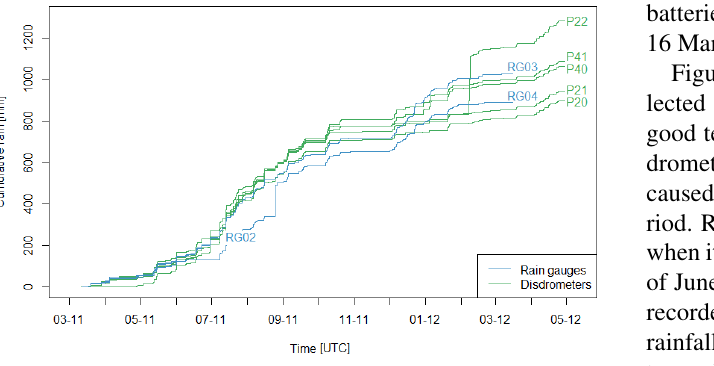
Figure 5. Comparison of cumulative rain of the three rain gauges and five disdrometers. There were several outages, suspicious mea- surements and technical issues recorded, such periods are further described in Sect. 2.5. Despite this, both types of devices are gener- ally in good